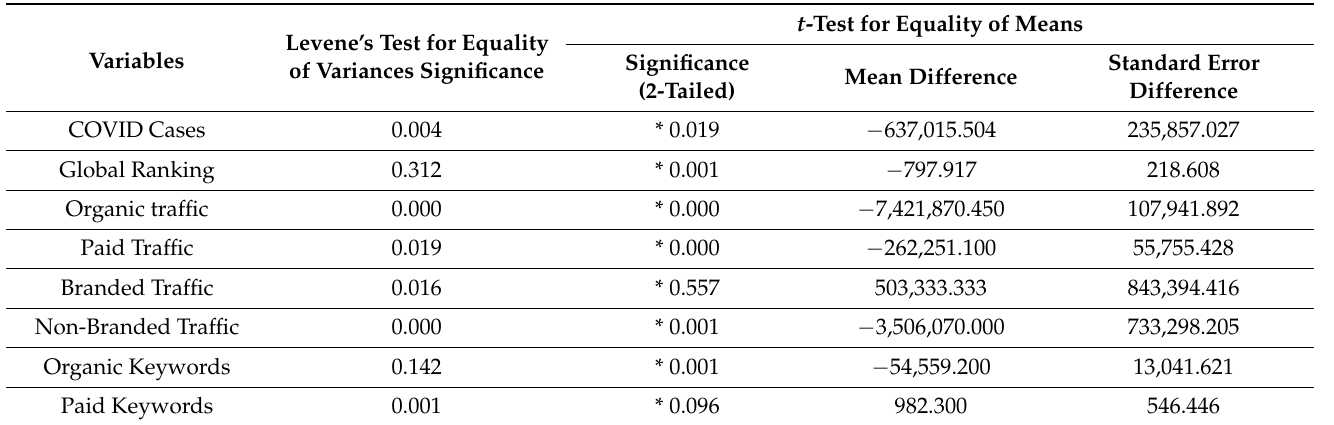
Table 4. Independent sample t -tests results between the COVID 1st 12-month period and COVID 2nd 12-month period data